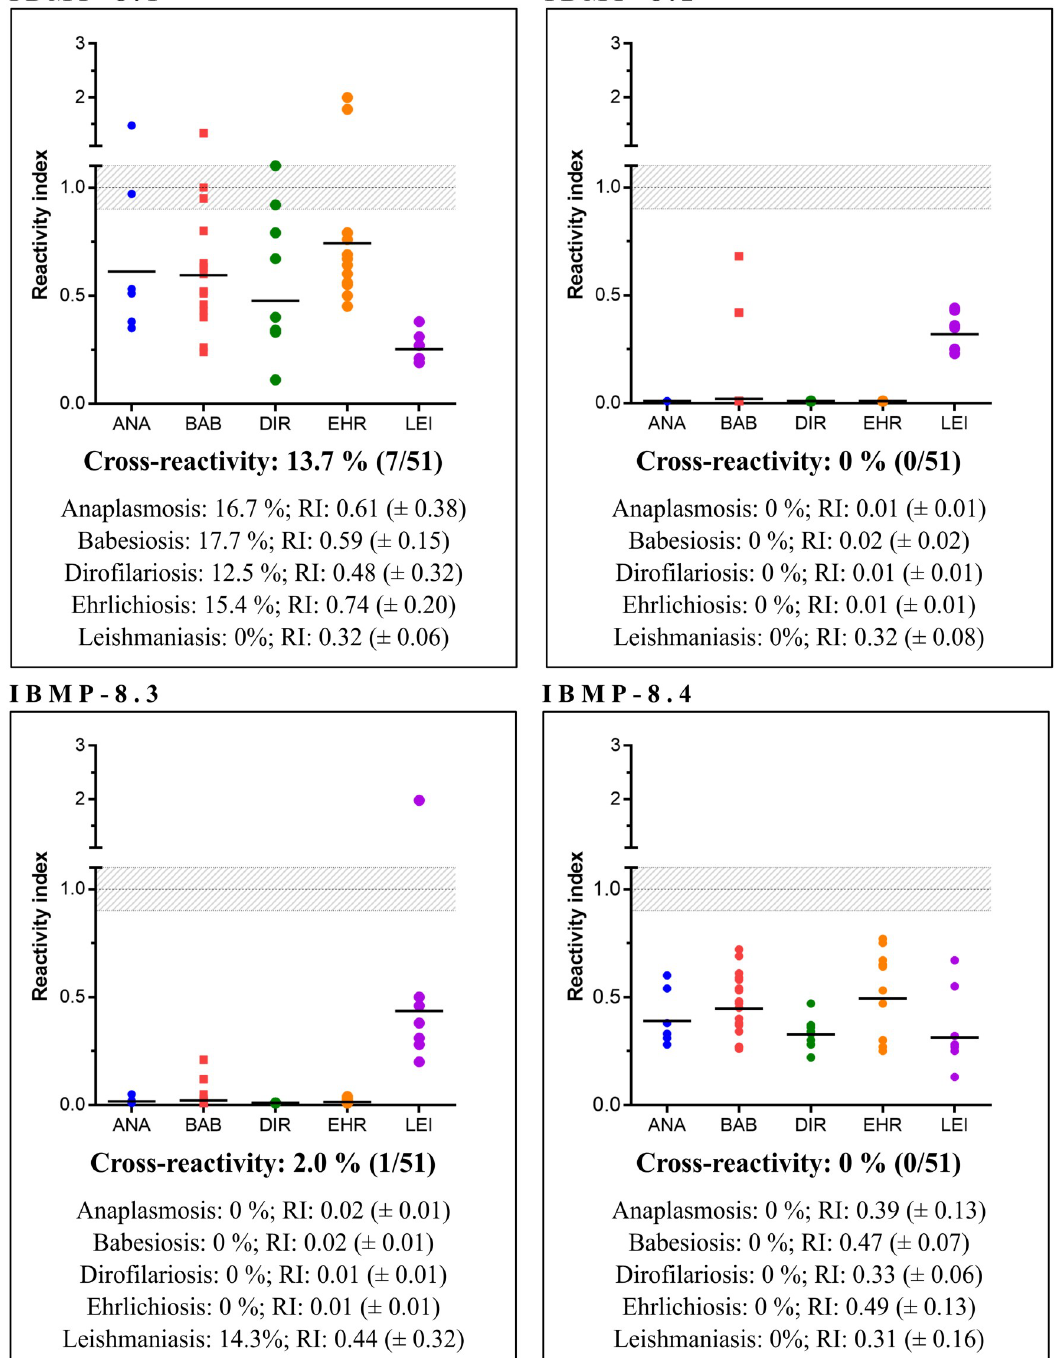
Fig 5. Analysis of IBMP chimeric antigens cross-reactivity with sera from dogs affected by unrelated parasites infection. The cut-off value is reactivity index = 1.0 and the shadowed area represents the grey zone (RI = 1.0 ± 0.10). ANA (anaplasmosis); BAB (babesiosis); DIR (dirofilariosis); EHR (ehrlichiosis); LEI (leishmaniasis).